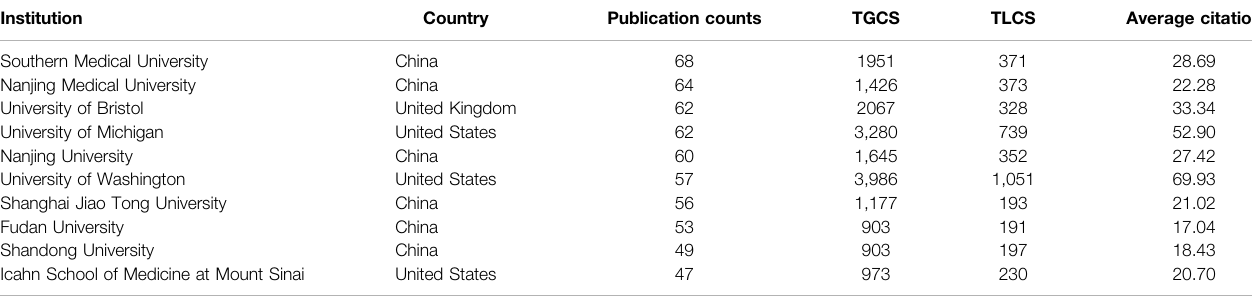
TABLE 2 | The top 10 productive institutions concerning podocyte injury research.